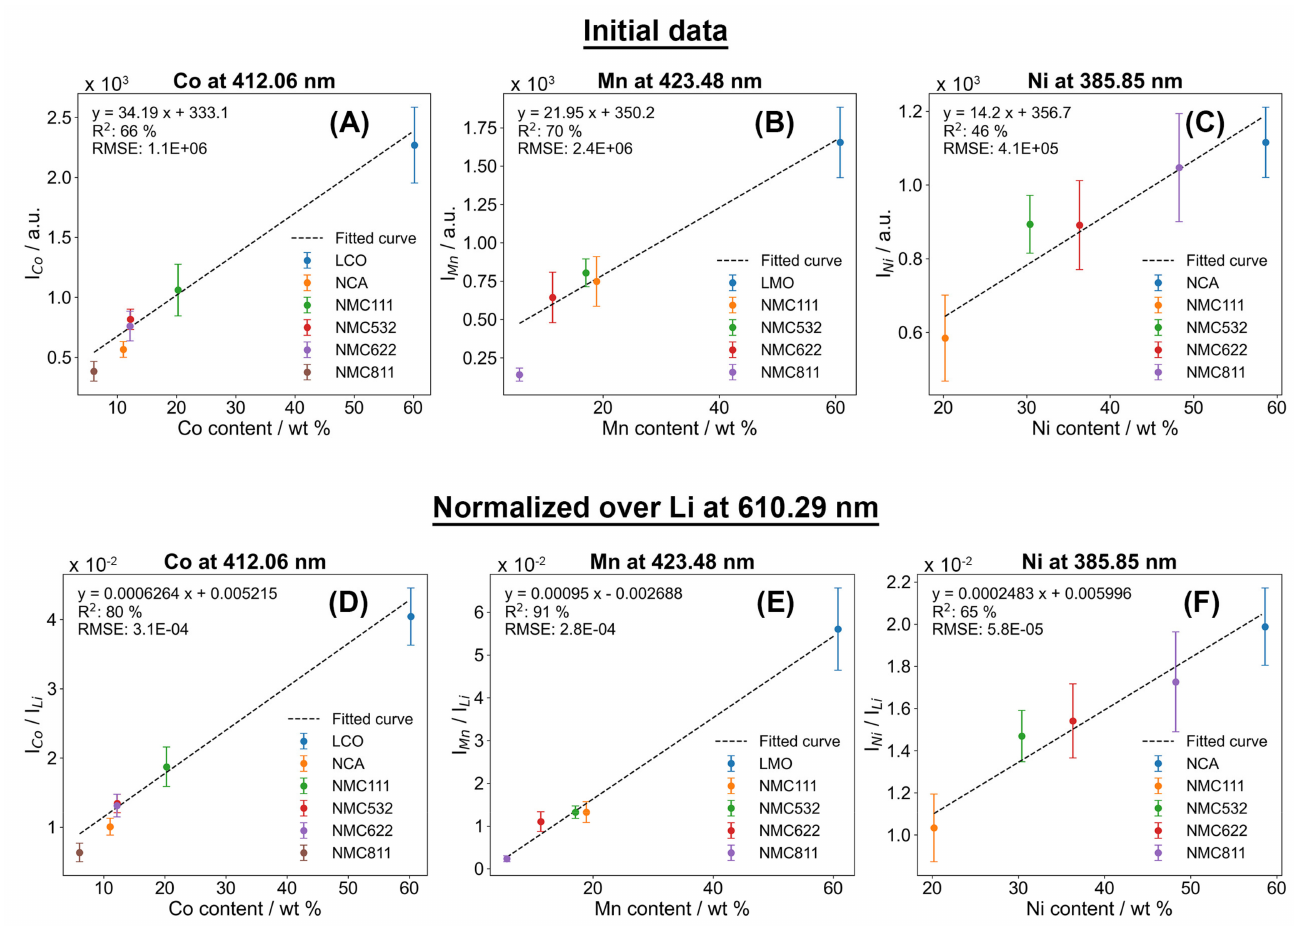
Figure 6. Intensities of ( A ) Co, ( B ) Mn, and ( C ) Ni emission lines with background removal and ( D ) Co, ( E ) Mn, and ( F ) Ni emission lines relative to Li at 610.29 nm as functions of their expected contents in different battery